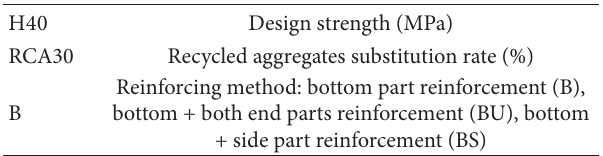
Table 1: The description of specimen group (H40-RCA30, H40-